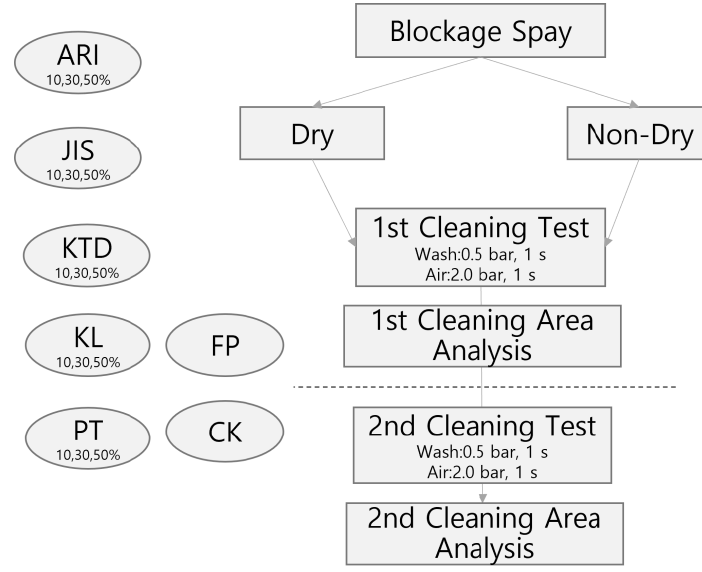
Figure 11. Blockage test flow chart.